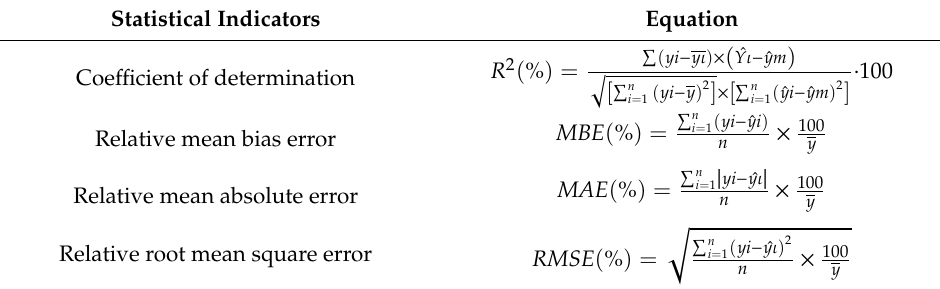
Table 3. Statistical indexes used to evaluate the e ffi ciencies of the